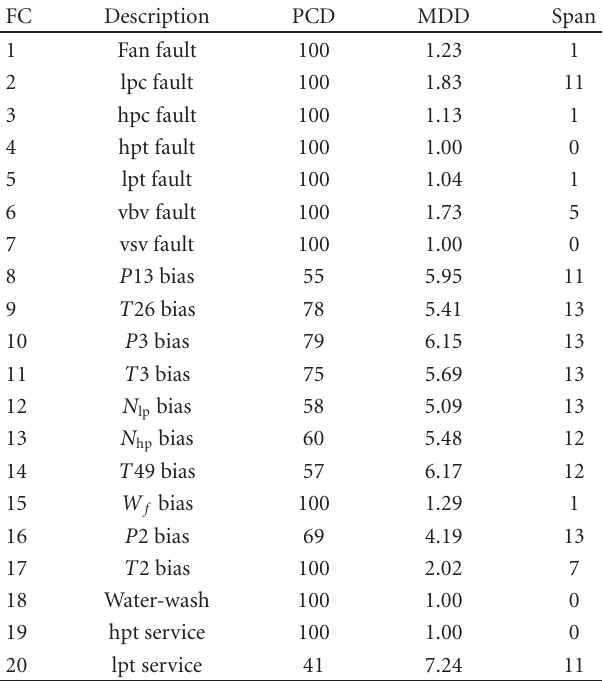
Table 6: Detection performance for the di ff erent events. Table 7: Minimum levels of bias (expressed in number of standard deviations σ ) for sensor fault